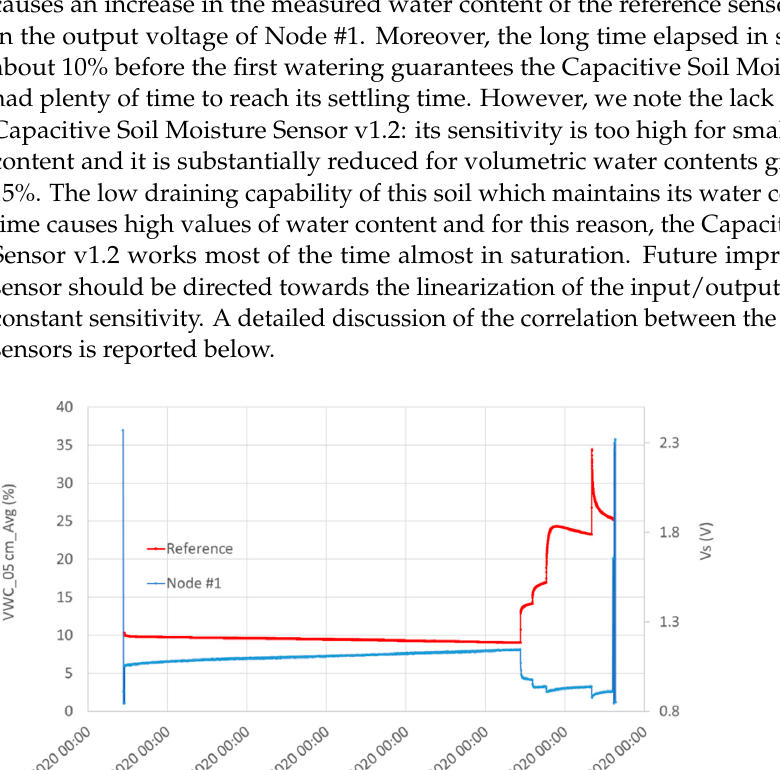
Figure 12. Water content measured by the reference system at two different depths in Silty Loam: red, 5 cm underground, and green, 15 cm underground.